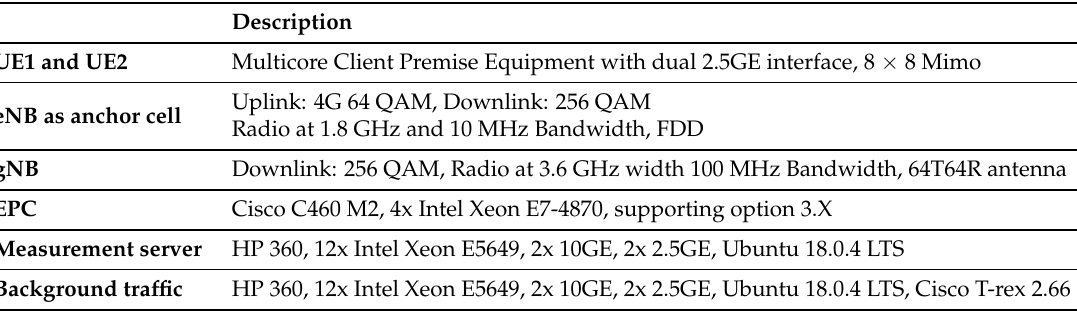
Table 5. HW and SW description of devices in the